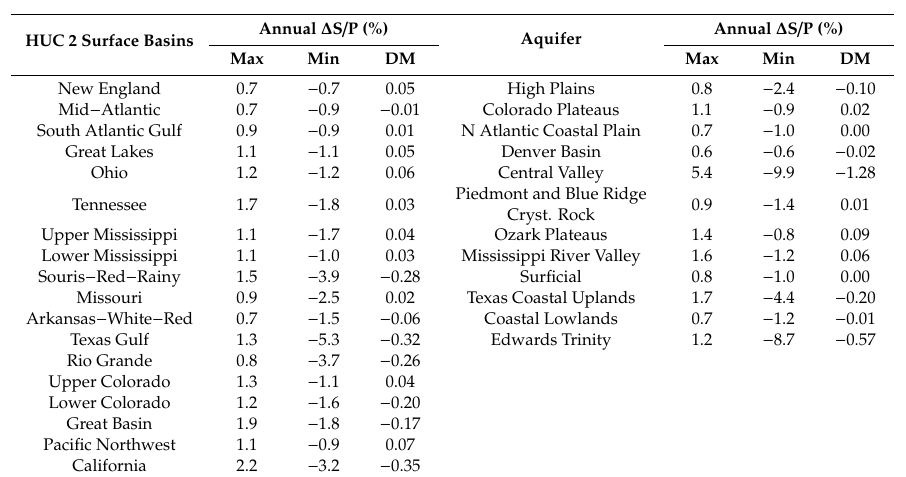
Table 1. Analysis of the ratio of month-to-month change in storage and P ( ∆ S / P) annual max, min, and decadal mean (DM) for each region to understand the significance of change in storage in the water